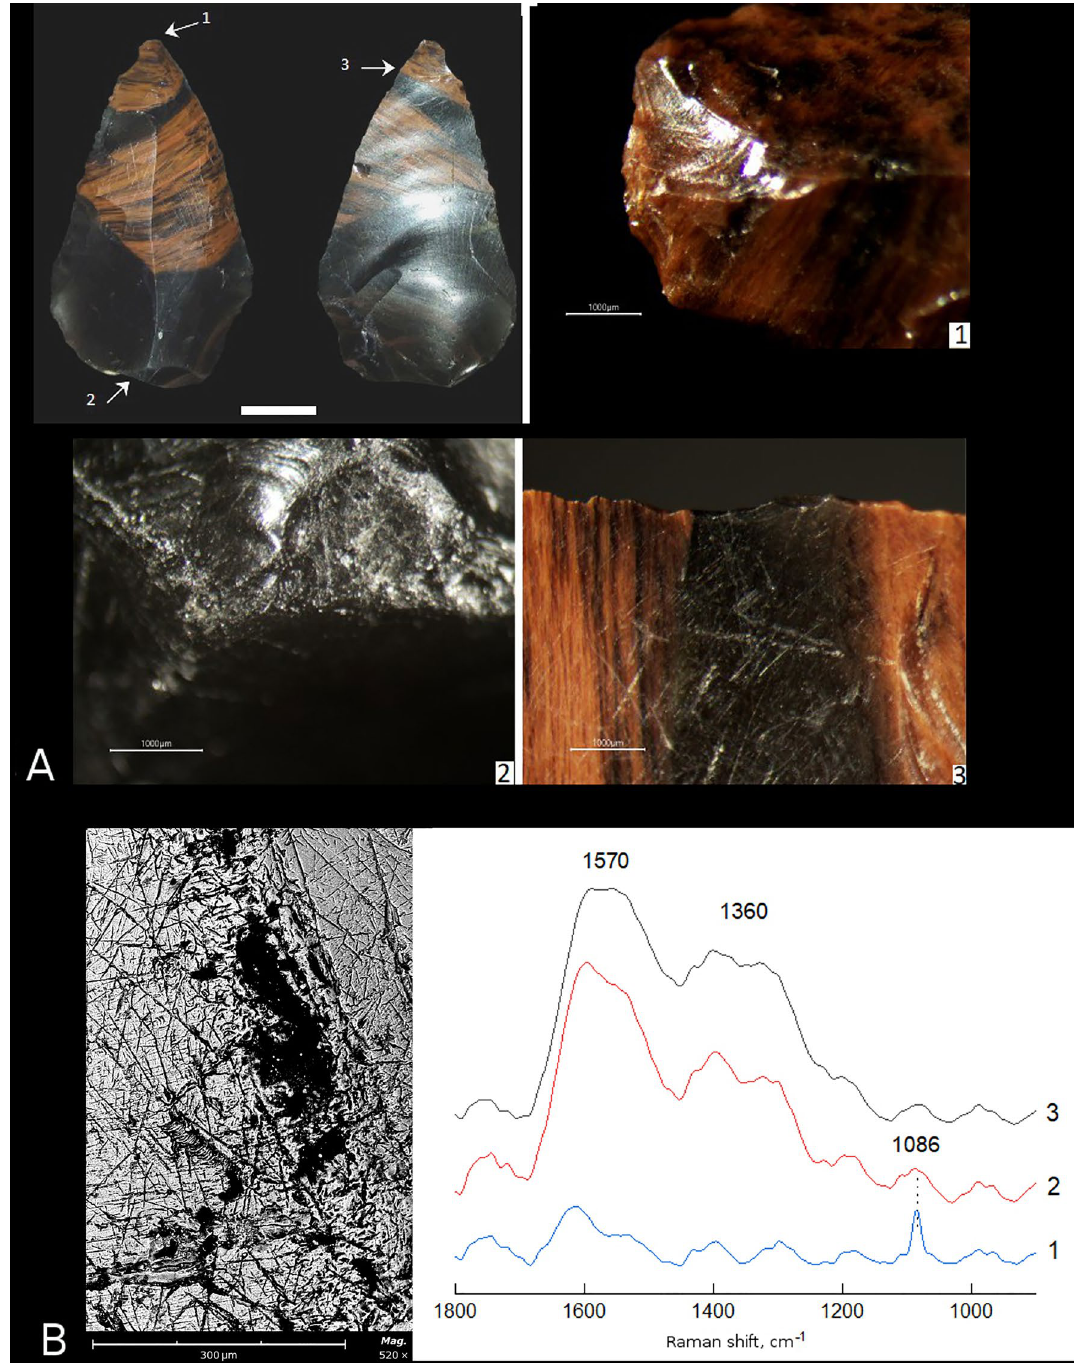
Figure 3. Use-wear and residue analyses of sample 2 from Layer 6B at Saradj-Chuko grotto. ( A ) Photo of sample 2, scale bar = 1 cm. The arrows indicate position of close-ups of use-wear traces shown on microscopic photos 1–3, scale bar = 1000 μm: (1) fractures on the tip, (2) crushing area on the tool base, (3) smoothing and linear striations along the tool edge. ( B ) SEM close-up on a sample of the black substance (bitumen residue) analyzed by FTIR and Raman spectroscopy, and Raman spectra of three residue